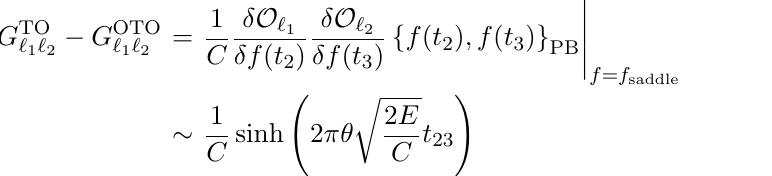
f ( (cid:27) 1 ) ; f ( (cid:27) 2 ) living f g